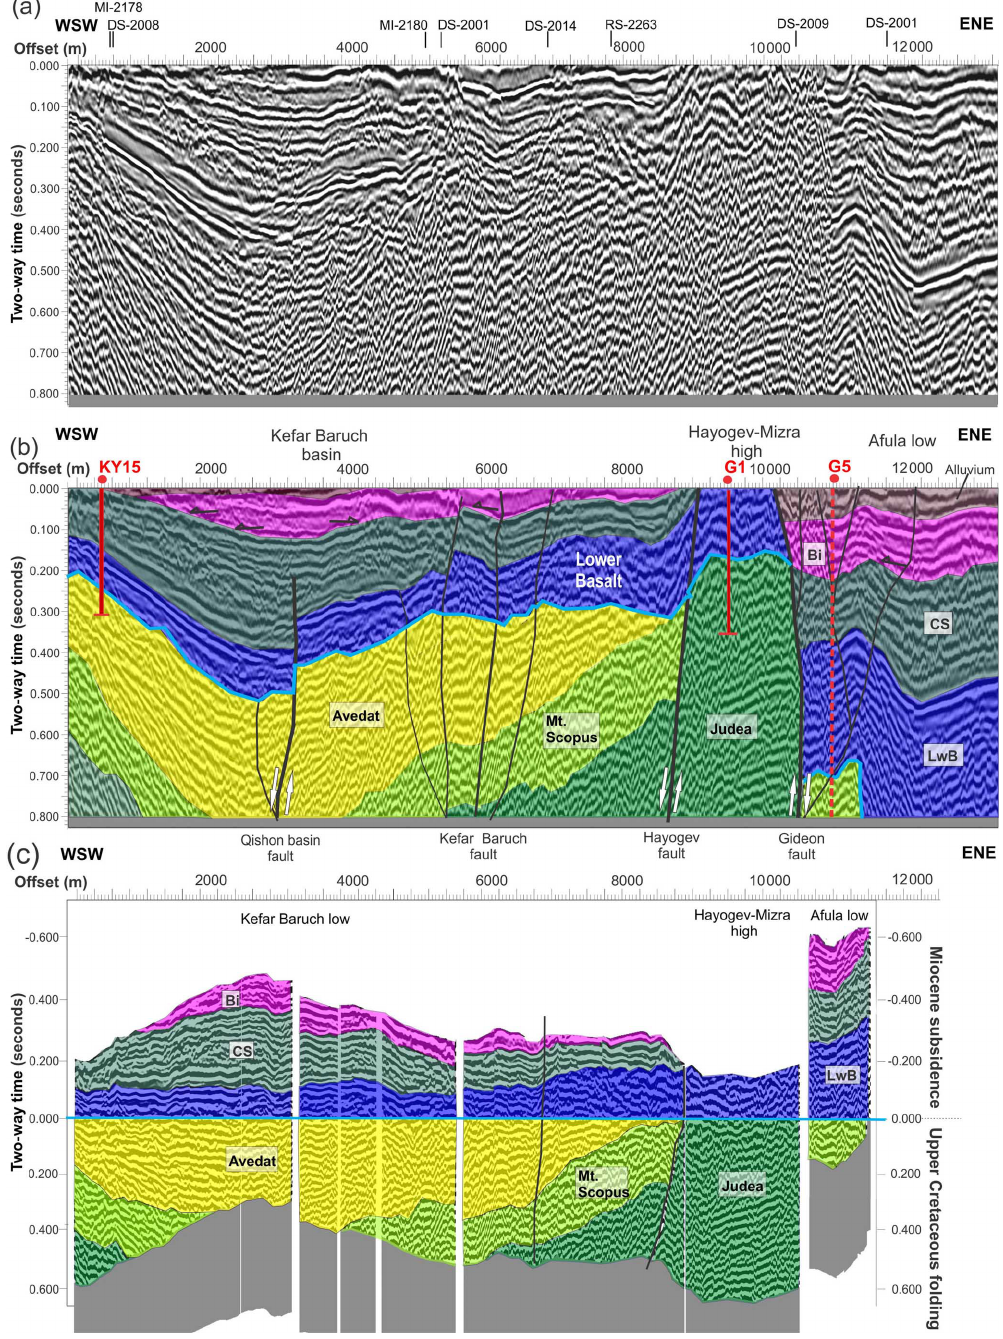
Figure 5. (a) Multichannel seismic reflection profile line MI-2187 crossing the basin axis (location: Fig. 3). (b) The RTS horizon (celeste) divides pre-truncation from post-truncation sediments. The Hayogev-Mizra horst (HMH) intervenes between Kefar Baruch and Afula Neo- gene basins. Cretaceous units at the syncline were interpreted using intersecting and overlapping deeper seismic profiles from the DS series (see Fig. S3). Boreholes KY15 – Kefar Yehoshua 15, G1 – Gideon 1, and G5 – Gideon 5, projected by 1km from the south (location: Fig. 3b, GE). Uppermost unit (gray): alluvium. (c) Same profile; flattening of the celeste horizon (RTS) to image the truncation. The flattening tool enables a comparison between predating and postdating sedimentary stacks. Flattening the RTS in the seismic software hints at RTS predat- ing and postdating main processes. For example, in Kefar Baruch basin, Cretaceous folding shown by a syncline predates the RTS, while Neogene subsidence, shown by an accumulation of Neogene sediments, postdates the RTS. Bi – Bira Formation; CS – Clay Series; LwB – Lower Basalt Formation. Groups: Avedat Group; Mt. Scopus Group; Judea Group. Vertical exaggeration: × 5.